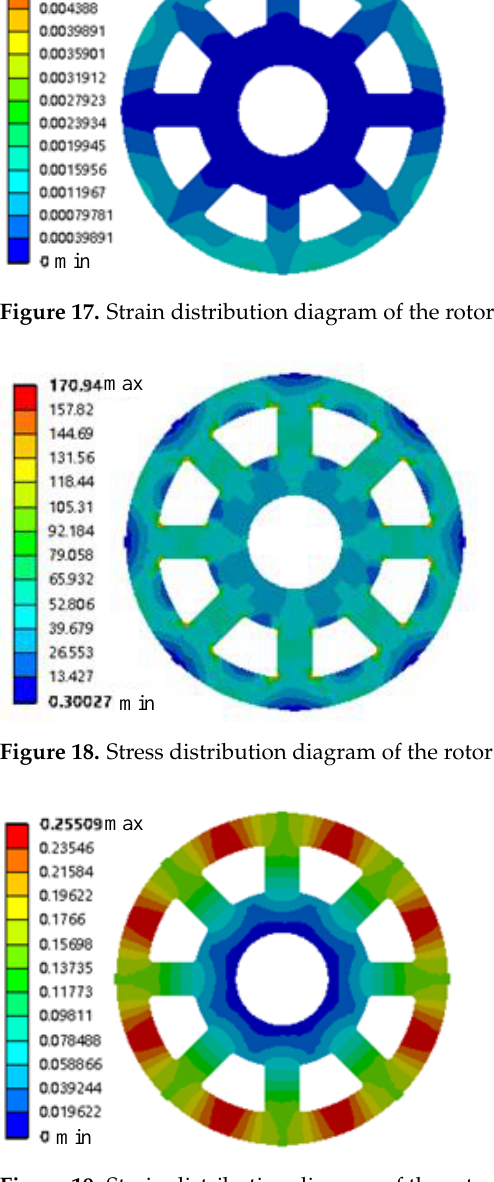
min Figure 19. Strain distribution diagram of the rotor runaway condition.